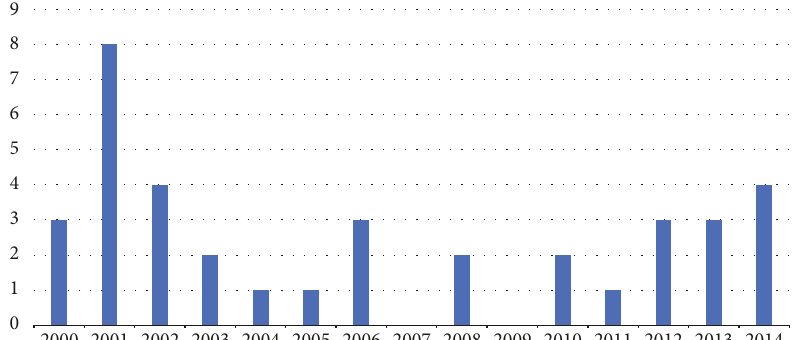
Figure 1: Year of article publication.